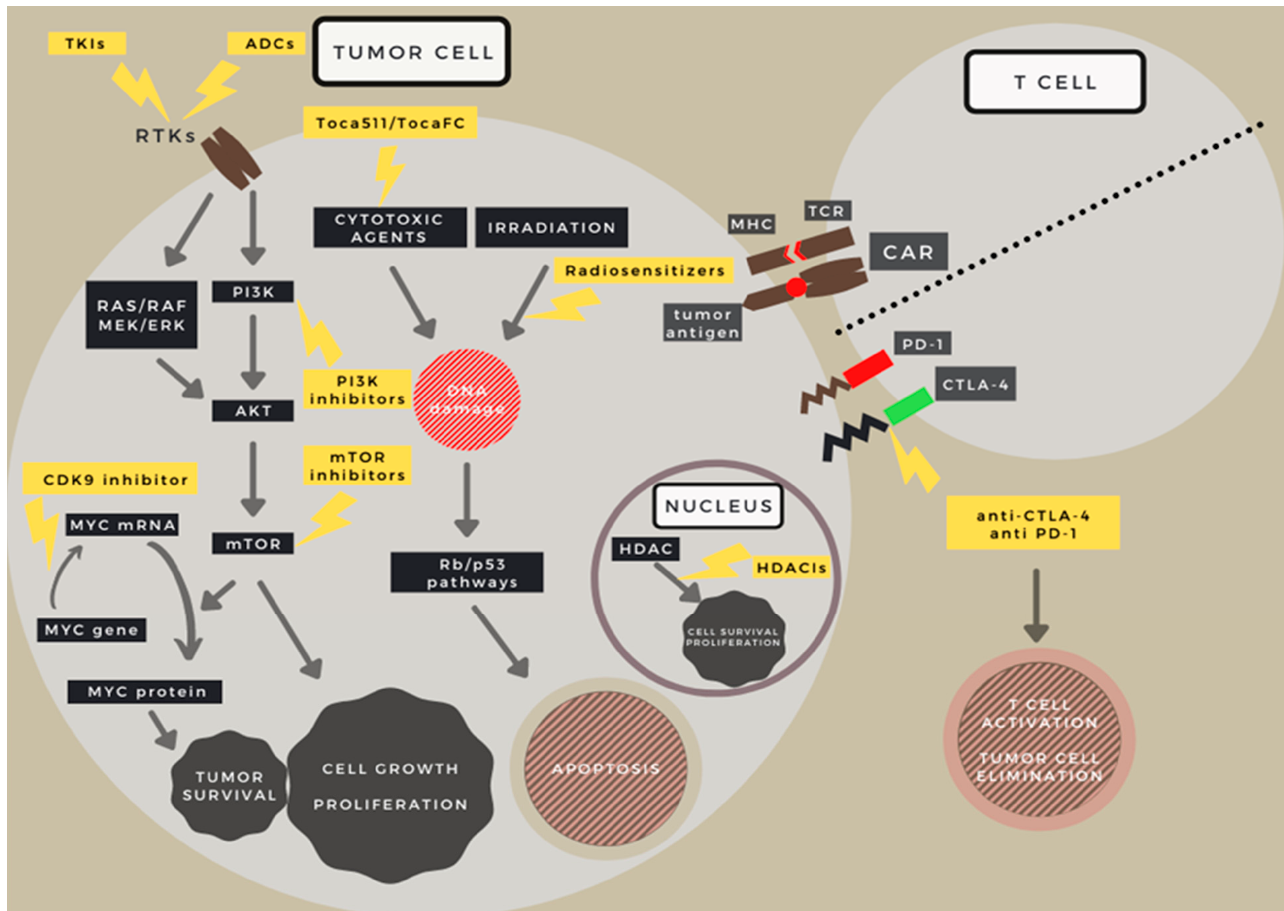
Figure 3. Targets of various drugs used in GBM treatment trials on a schematic depiction. Target locations of new therapeutic directions in GBM. RTK (-RAS-PI3K-mTOR), TP53 and RB pathways and the tumor cell–T cell connections are visualized schematically. Abbreviations: TKIs: Tyrosine kinase inhibitors; ADCs: Antibody drug conjugates; CDK9: Cyclin Dependent Kinase 9; RTKs: Receptor tyrosine kinases; RAS: Rat sarcoma virus protein family; Raf: Serine/threonine-specific protein kinase family; MEK: Mitogen-activated protein kinase; ERK: Extracellular signal-regulated kinase; PI3K: Phosphoinositide 3-kinase; AKT: Serine/threonine protein kinase family; mTOR: mechanistic target of rapamycin; Myc: Regulator gene and proto-oncogene family; HDAC: Histone deacetylase; HDACIs: Histone deacetylase inhibitors; TCR: T cell receptor; MHC: Major histocompatibility complex; CAR: Chimeric Antigen Receptor; PD-1: Programmed cell death protein 1; CTLA-4: Cytotoxic T-lymphocyte-associated protein 4; Rb: Retinoblastoma; p53: Cellular tumor antigene p53.